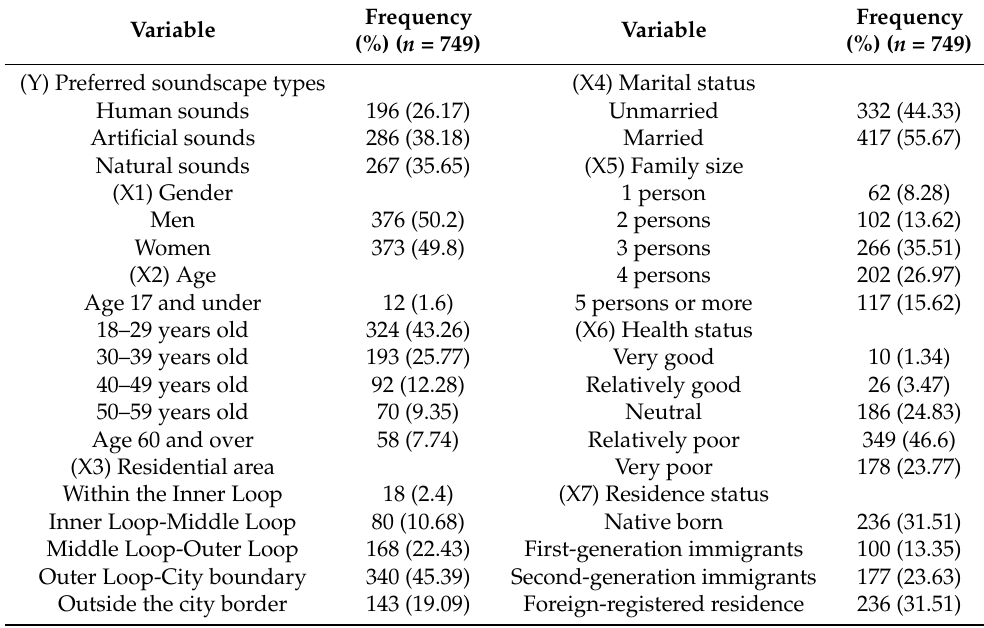
Table 4. Descriptive statistics of the